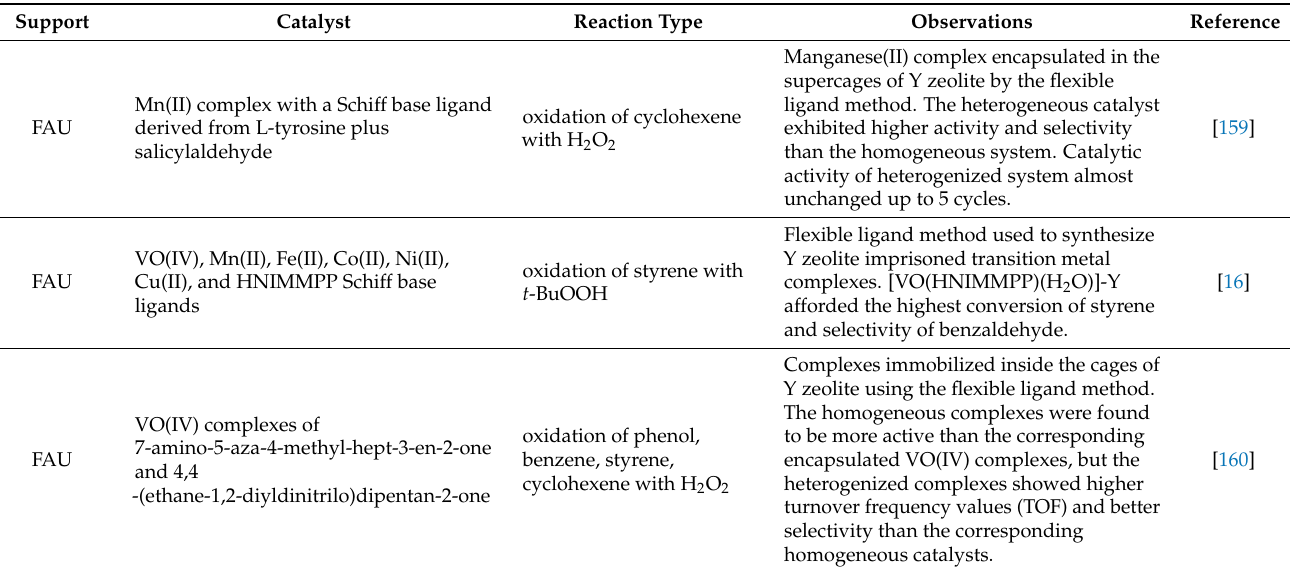
Table 4. Catalytic applications of commercial/hierarchical zeolites and other related materials as catalyst supports for oxidation of